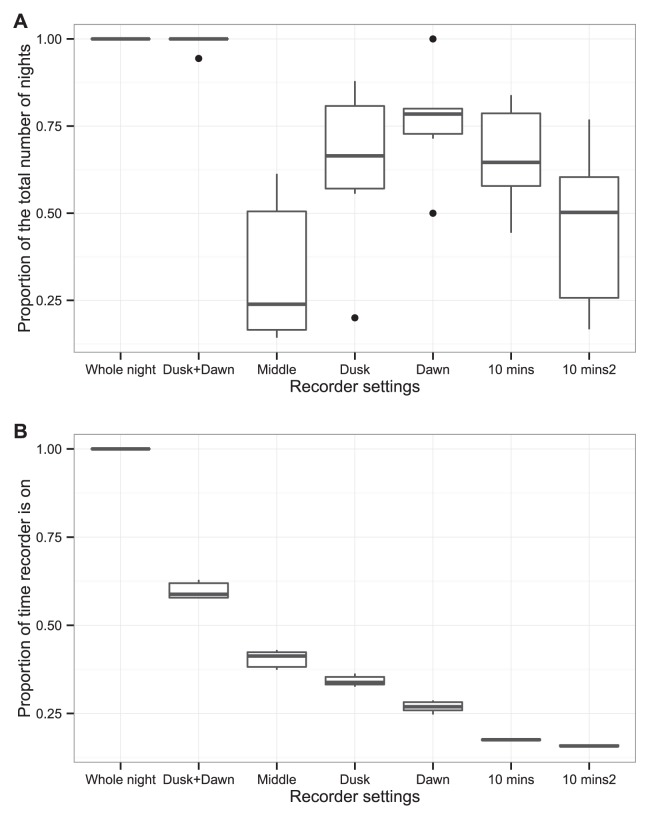
Proportion of the total number of nights nightjars were detected using different recorder settings.(a) We plotted the following recorder settings: dusk (22.00–00.00), middle of the night (00.00–02.30), dawn (02.30–04.30), dusk and dawn combined, and two random samples of ten minutes per hour (“10 mins” and “10 mins2”), and compared these to the total nights nightjars were detected when the recorders were left on during the whole night. (b) The relative length of each of these recording periods compared to recording the whole night. Our results indicate that most nightjar activity occurs during dusk and dawn; as a result, activating the recorders during these periods captures almost all (98.8%) of the nightjar activity, even though these periods make up only 60% of the night. The variability among the two 10-minute subsamples suggests that this is an unreliable sampling strategy for detecting nightjar activity.